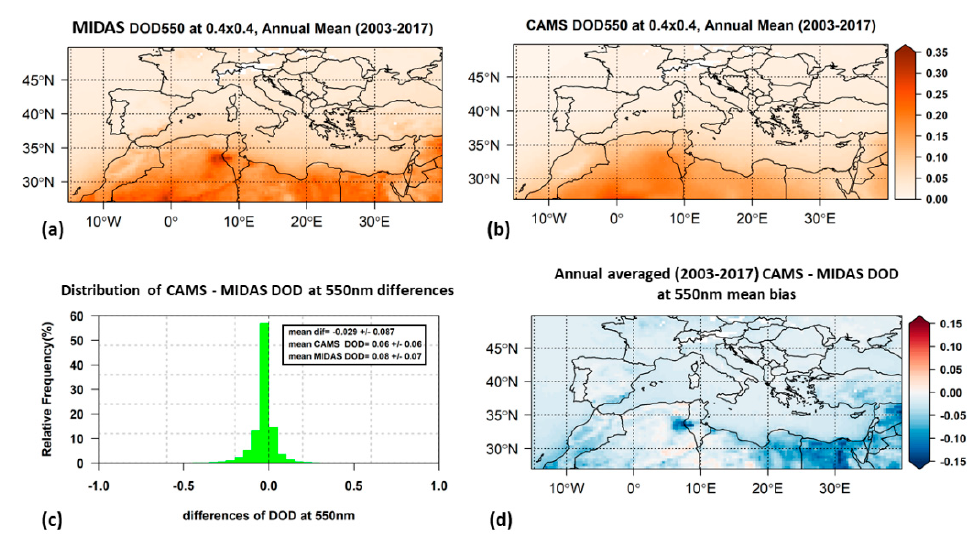
Figure 5. Geographical distribution of long-term average of annual mean DOD at 550 nm from MIDAS ( a ) and CAMS ( b ). Frequency distribution of CAMS–MIDAS DOD biases with their mean value ( c ) and geographical distribution of annual mean biases ( d ). Blank grid points are those that did not fulfill the criterion of at least 20% data availability on annual basis.